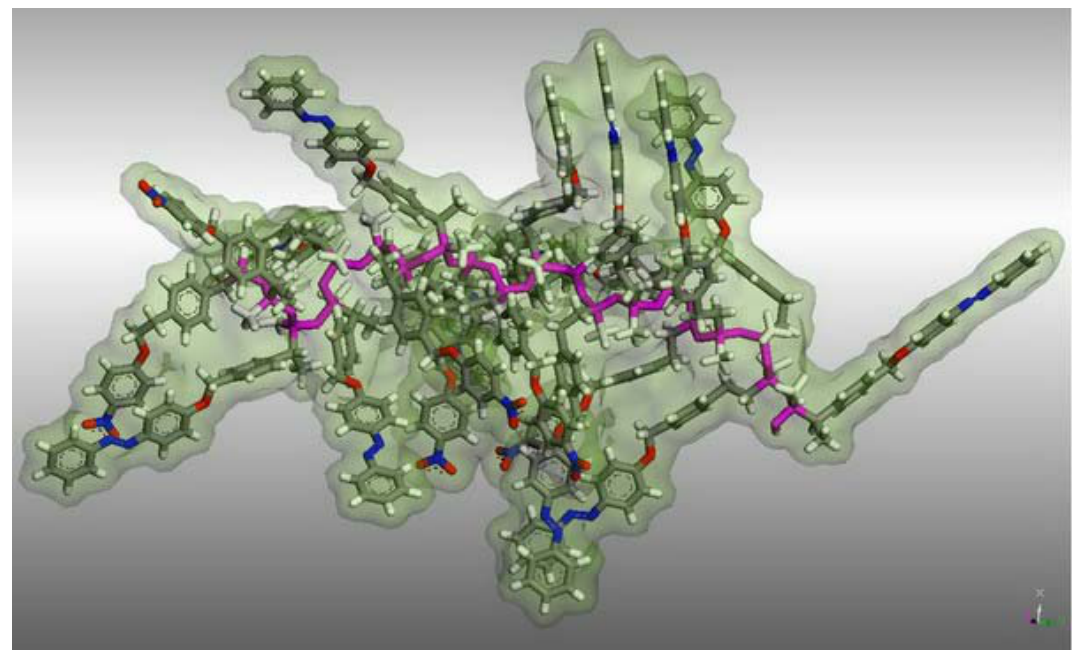
Fig. 6 Minimum energy geometry corresponding to an azo-polysiloxane modified with nitrophenolic